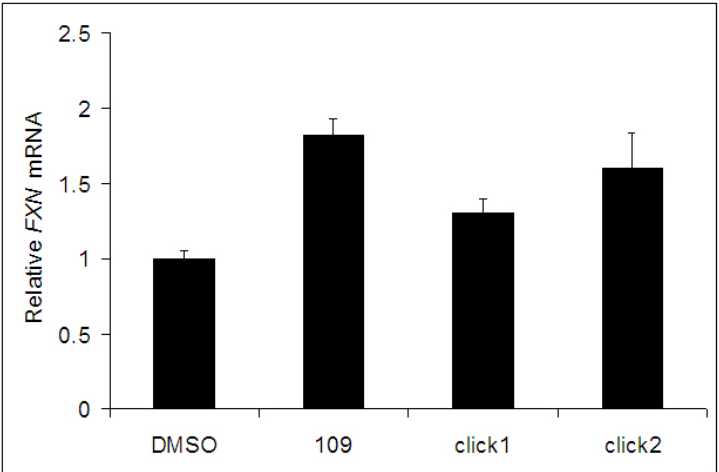
Figure 3. Click-derived HDAC inhibitors induce frataxin gene expression in primary lymphocytes isolated from FRDA patient donor blood samples, compared to a standard pimelic o -aminobenzamide ( 109 ). Concentration of each compound is 10